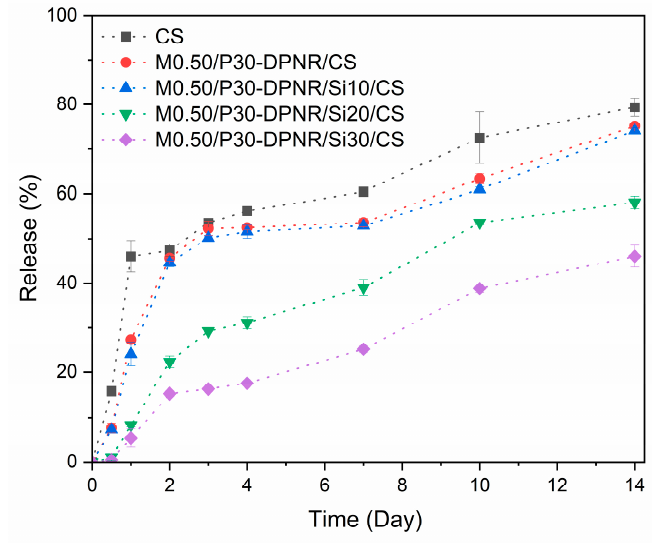
Figure 14. Release profiles of KNO 3 from different types of natural rubber/silica-coated CS beads. Table 4. Release parameters of release kinetic